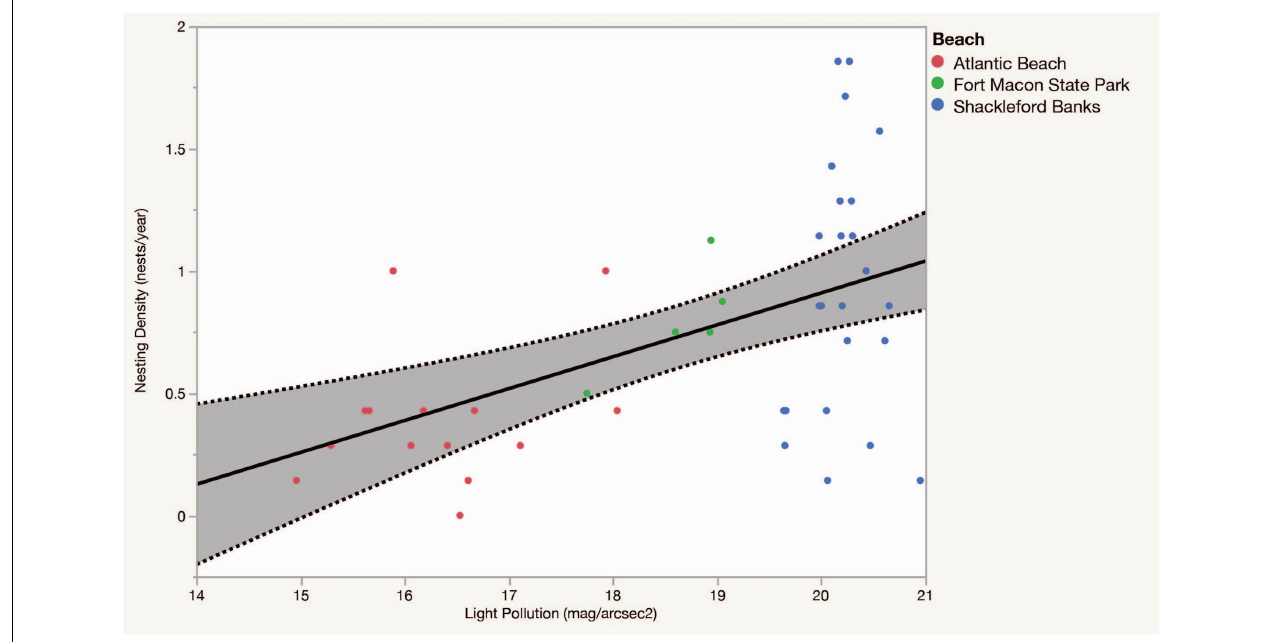
FIGURE 6 | Linear regression ( n = 44, R 2 = 0.28, p = 0.0002) of nesting density (nests/year) and light pollution (mag/arcsec 2 ) per 500-m bin on Atlantic Beach, Fort Macon State Park, and Shackleford Banks, NC sampled during the summer of 2017. Line of best fit: nesting density = –1.70 + 0.13 ∗ light pollution. Dashed lines represent 95% confidence interval for mean nesting density for a given value of light